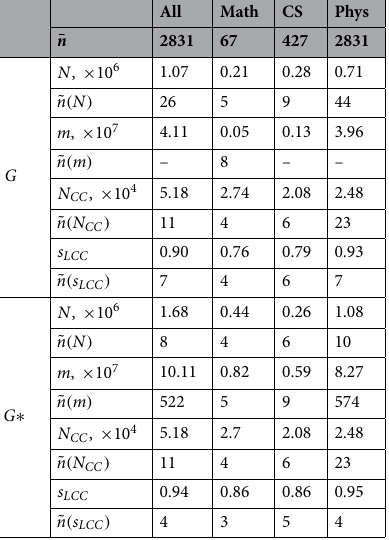
Table 1. Maturation indices and maturation values of the main general properties of primal and dual graphs. All notations and definitions are reported in the text. The symbol “–” reflects the fact that the property does not maturate, implying that significant changes in the property’s value occur at all fusion indices, up to the final layer (the reported values are therefore the “asymptotic” ones obtained by fusing all layers).